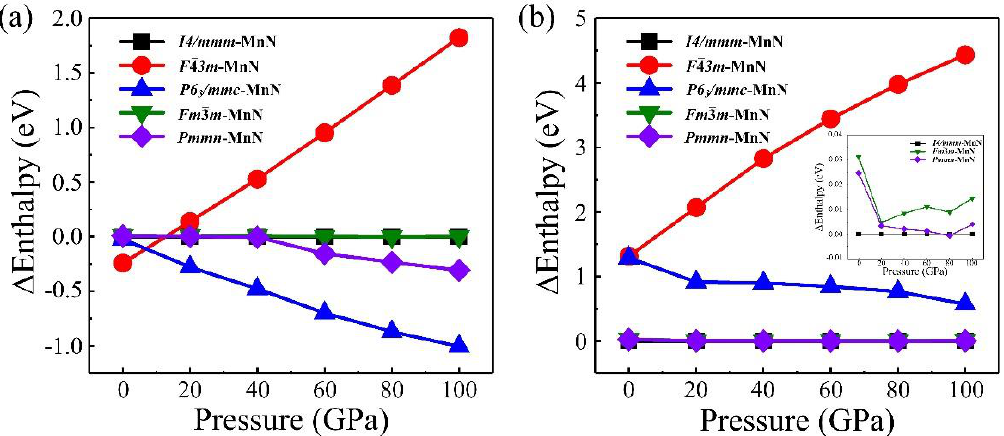
Figure 4. Enthalpies of MnN are shown as a function of pressure based on the DFT method ( a ) and DFT + U method ( b ). The enthalpy of MnN in phase A is set to zero, and contrasts between enthalpies of different phases are shown more clearly in the insets of ( b ).